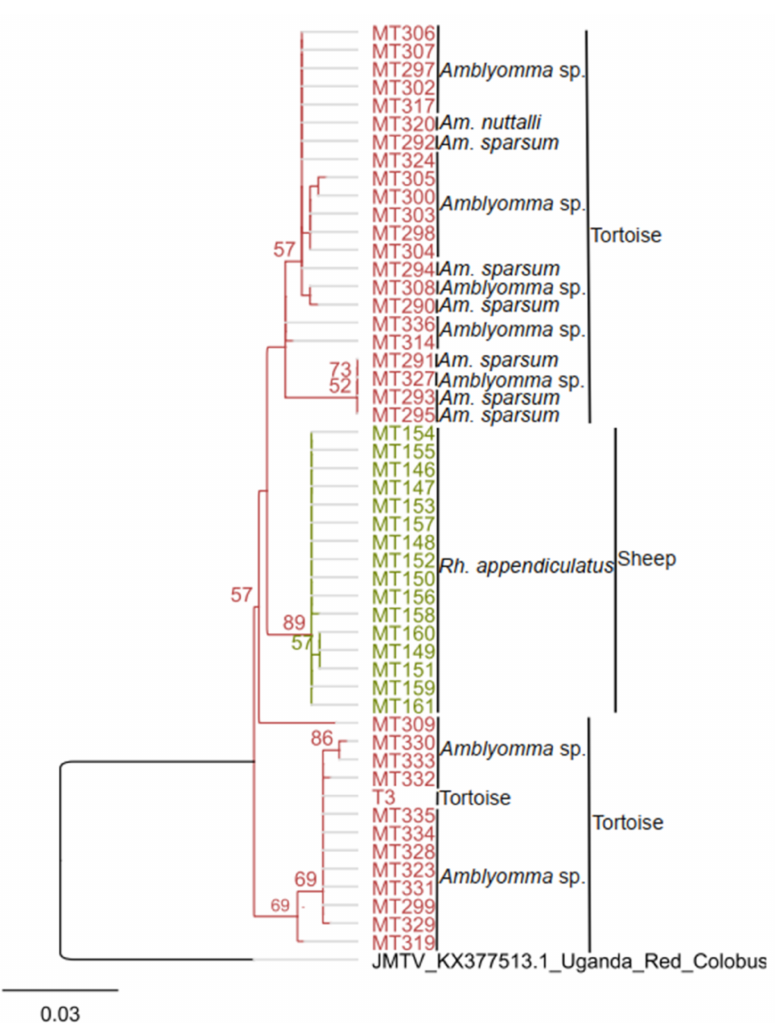
Figure 2. Phylogenetic relationship of detected JMTV sequences. The ML phylogenetic analysis is based on a 489-nucleotide fragment of the NS5 gene. Sequences detected in the study and a JMTV reference sequence from Uganda (KX377513.1) were aligned using MAFFT and tree inferred using PhyML v. 2.2.4 with GTR substitution models employing 1000 bootstrap replicates. Trees are midpoint rooted. Only bootstrap values exceeding 50% are shown. Species information of infected ticks and the hosts from which ticks have been collected are